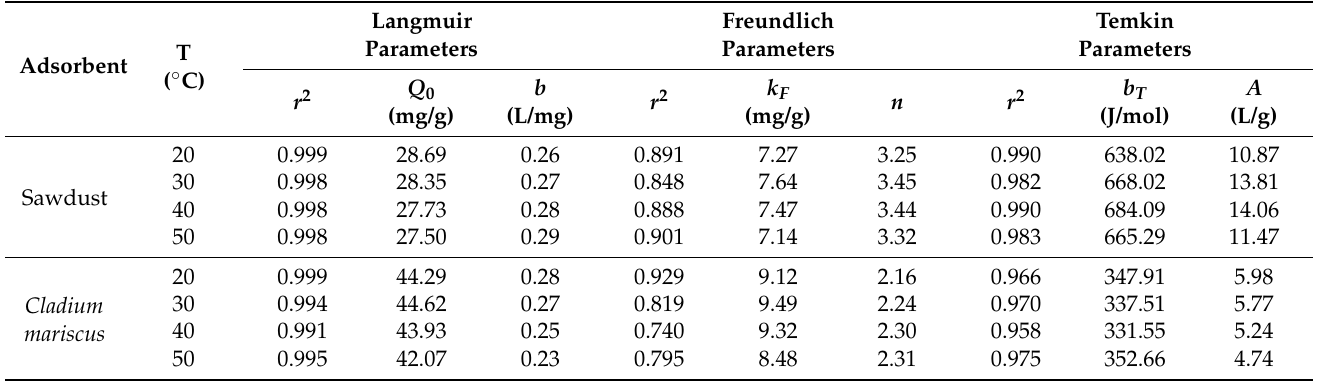
Table 4. Isotherm constants for BB3 adsorption on sawdust and Cladium mariscus saw-sedge at 20–50 ◦